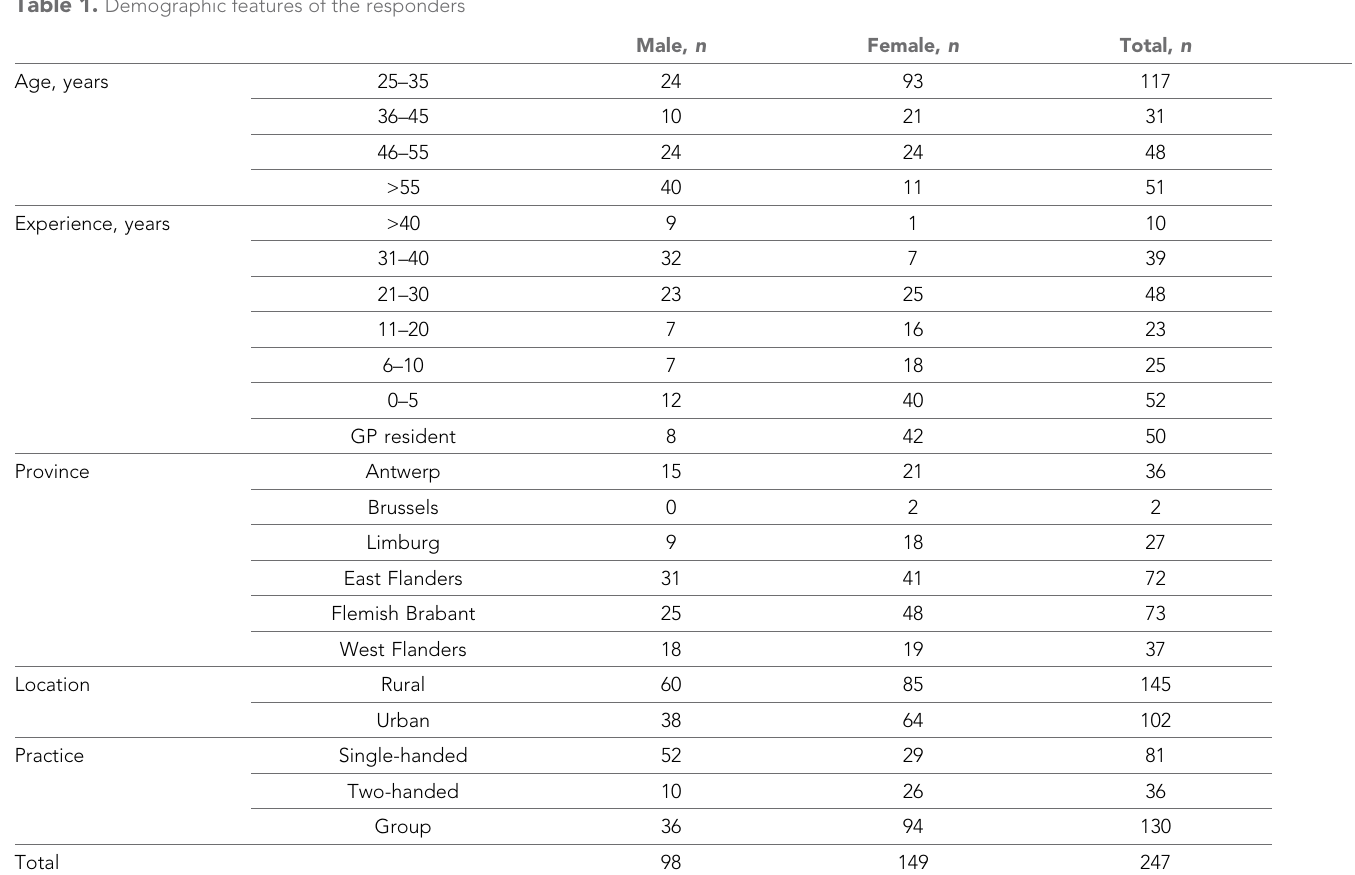
Table 1. Demographic features of the